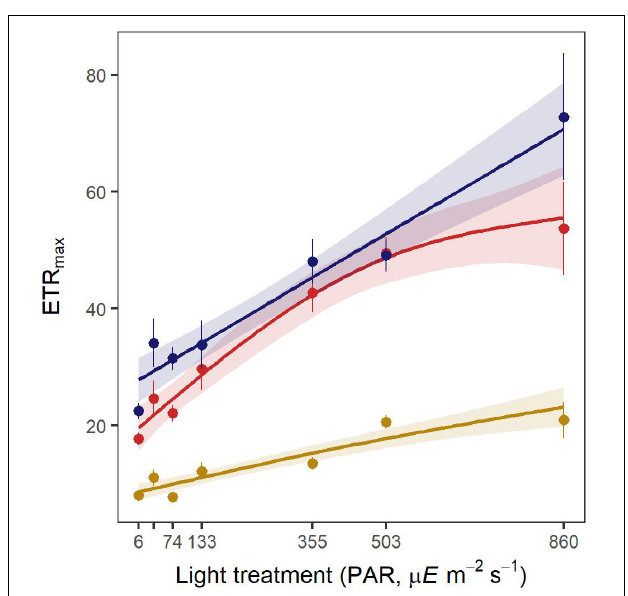
are mean ± SE ( n = 5–9 shoots) uncorrected ETR max (red, with default AF of 0.44) and rates corrected with the measured AF total and AF photo (blue and yellow, respectively). Lines represent the fitted values from HGAM models with a 95%